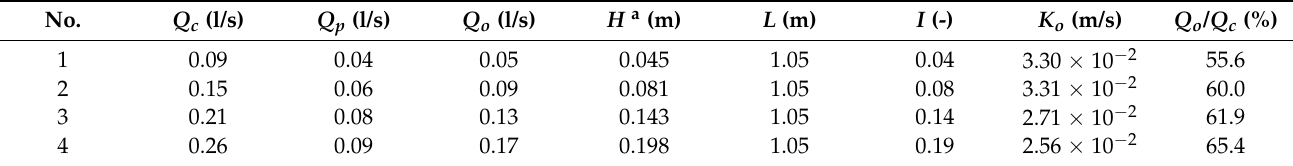
Table 4. Scenario A on a laboratory model of an extraction